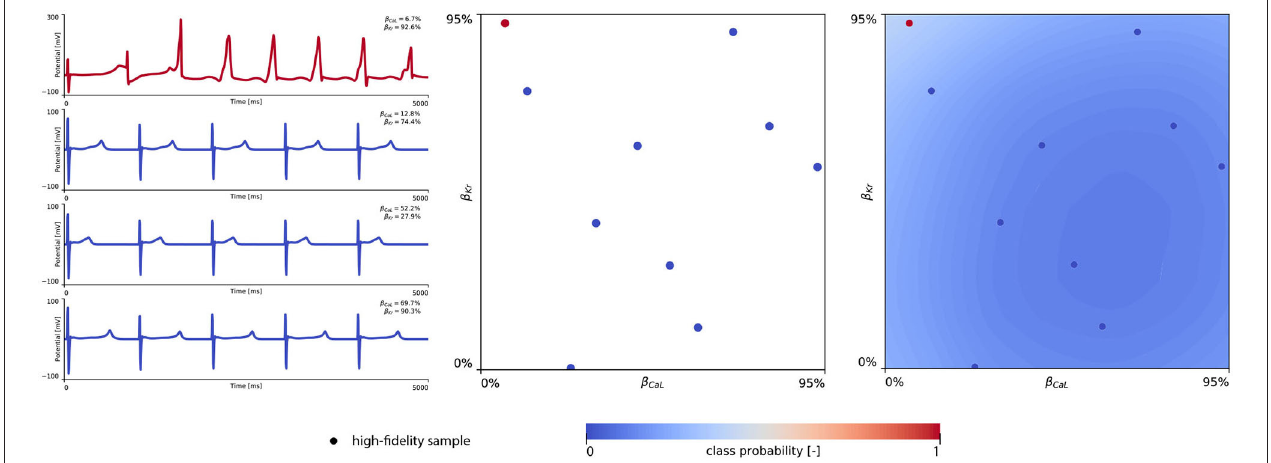
FIGURE A3 | Male single-fidelity multiscale arrhythmia risk classifier. Initial single high-fidelity exploration of the male drug-induced arrhythmogenic risk parameter space. The middle plot showcases 10 internal latin hypercube { β Kr , β CaL } sample evaluations of arrhythmogenesis in the male heart. The virtual electrocardiograms for one arrhythmogenic and three non-arrhythmic sample evaluations are shown in the left plots. The resulting exploratory male single high-fidelity drug-induced arrhythmogenic risk classifier is shown in the right plot.